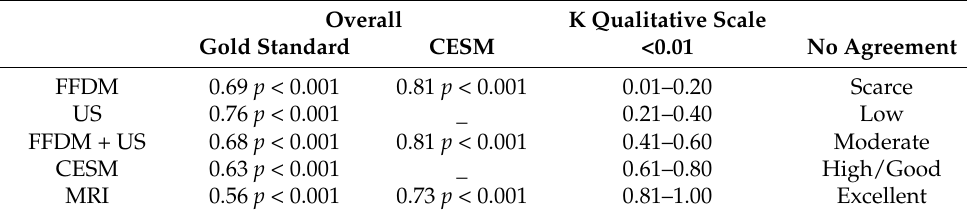
Table 4. Concordance analysis between imaging techniques. Per lesion approach ( N : 142).